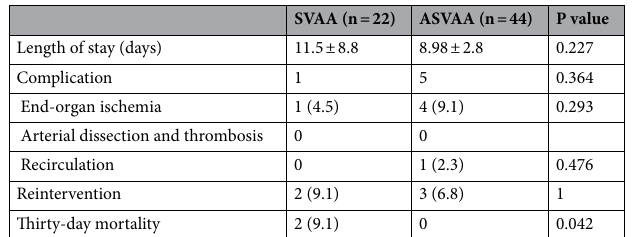
Table 3. Complications and perioperative outcome between symptomatic visceral artery aneurysm (SVAA) and asymptomatic visceral artery aneurysm (ASVAA) groups.